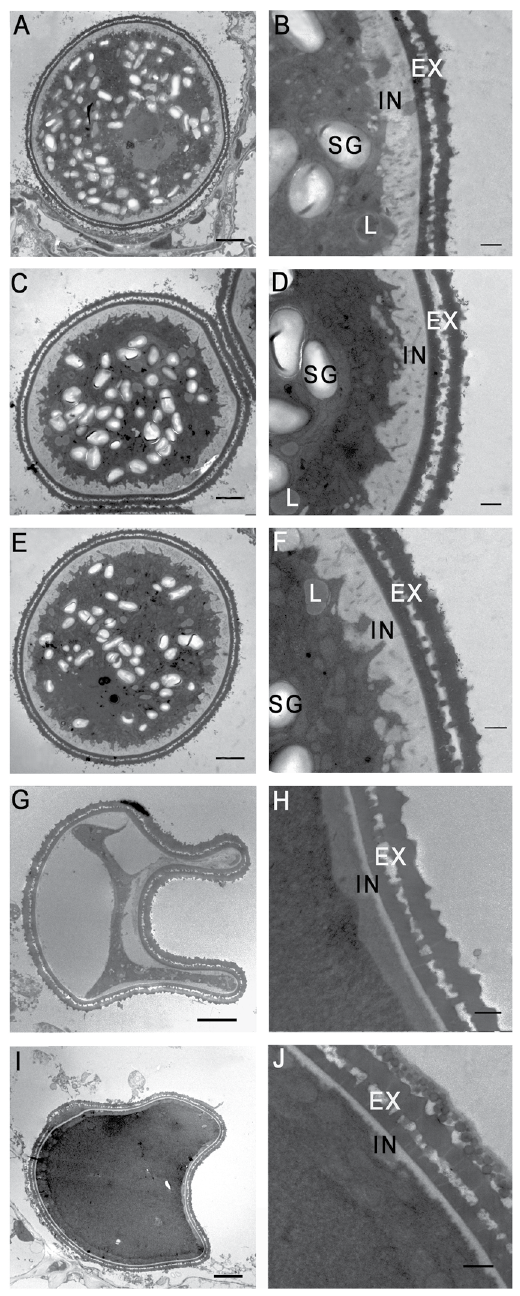
Figure 3. Transmission electron microscopic analysis of pollen grains in the phyA and phyB single and double mutants, and wild-type (WT) rice at stage 12. Cross sections of pollen grains from WT ( A and B ), the phyA mutant ( C and D ), the phyB mutant ( E and F ), the phyA phyB mutant ( G – J ). EX, exine layer; IN, intine layer; SG, starch granule; L, lipid body. Bars = 5 µ m in ( A , C , E , G and I ) 1 µ m in ( B , D , F , H and J